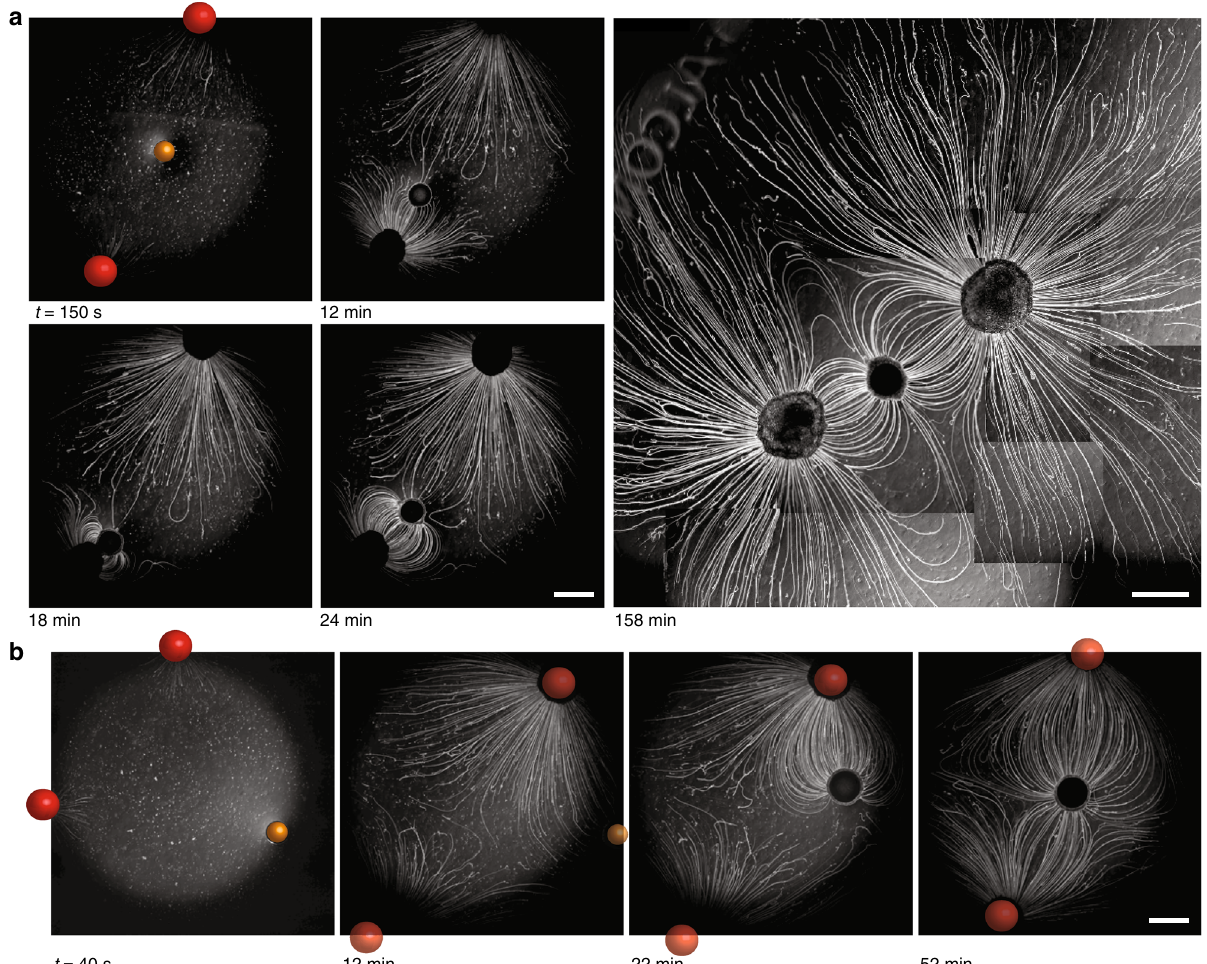
Fig. 6 Capture and positioning of droplets by balancing Marangoni fl ow and absorption of fi laments. a Optical microscopy recording of the positioning process of a drain droplet (orange sphere) in between two source droplets (red spheres) after deposition at the air – water interface. As the fi laments grew from the source droplets and tethered the drain droplet, they established a stable, interconnected droplet network. The wide- fi eld image acquired at t = 158 min is composed of multiple microscopy images. b Optical microscopy recording of the positioning process after deposition of the drain droplet off- centered to the two source droplets. Absorption of fi laments drew the drain towards the top source, and subsequently, upon absorption of fi laments from the bottom source, the drain was positioned in between the two source droplets. The scale bars represent 2